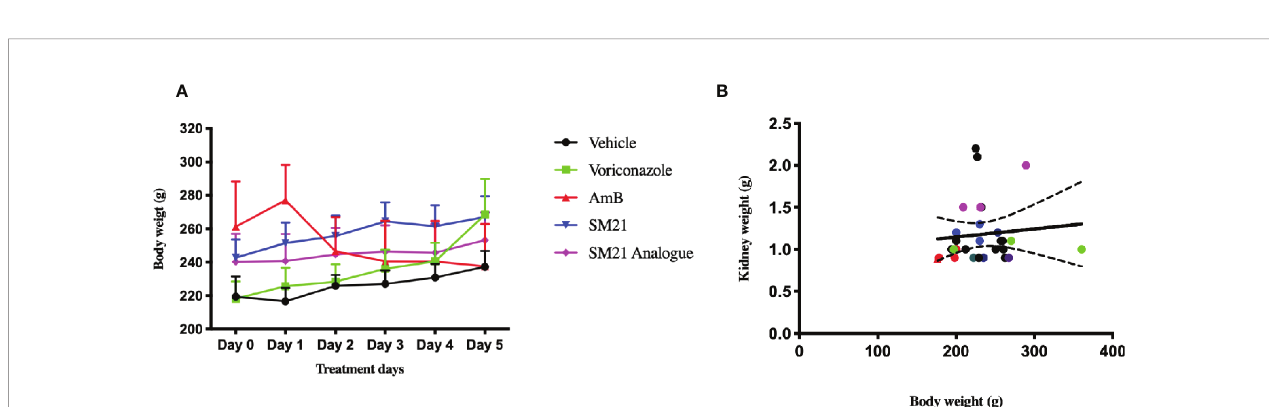
FIGURE 4 | Change in kidney and body weights of male Sprague Dawley rats, (A) Mean body weight change in each group at 15 mg/kg/day BW over treatment period of 5 days. There were no clinical signs of toxicity at any time point and decrease in group mean body weights were observed in SM21 and analogue treatment groups in parallel with vehicle and negative control (Voriconazole) from day 1 to day 5. Whereas in Amphotericin B group, two of nine rats were removed on day 3 due to overt sign of toxicity at 15 mg/kg and slight decrease in body weight gain ( – 8%) compared with vehicle was observed in the rest of rats from day 1 to day 5. (B) Correlation between kidney weight and body weight of rats in each group on day 5. Kidney weights data were subjected to the linear regression and correlation was established with corresponding body weights using Prism's correlation matrix. There is poor or no correlation was found of kidney weights with body weights in the present study (P > 0.05).